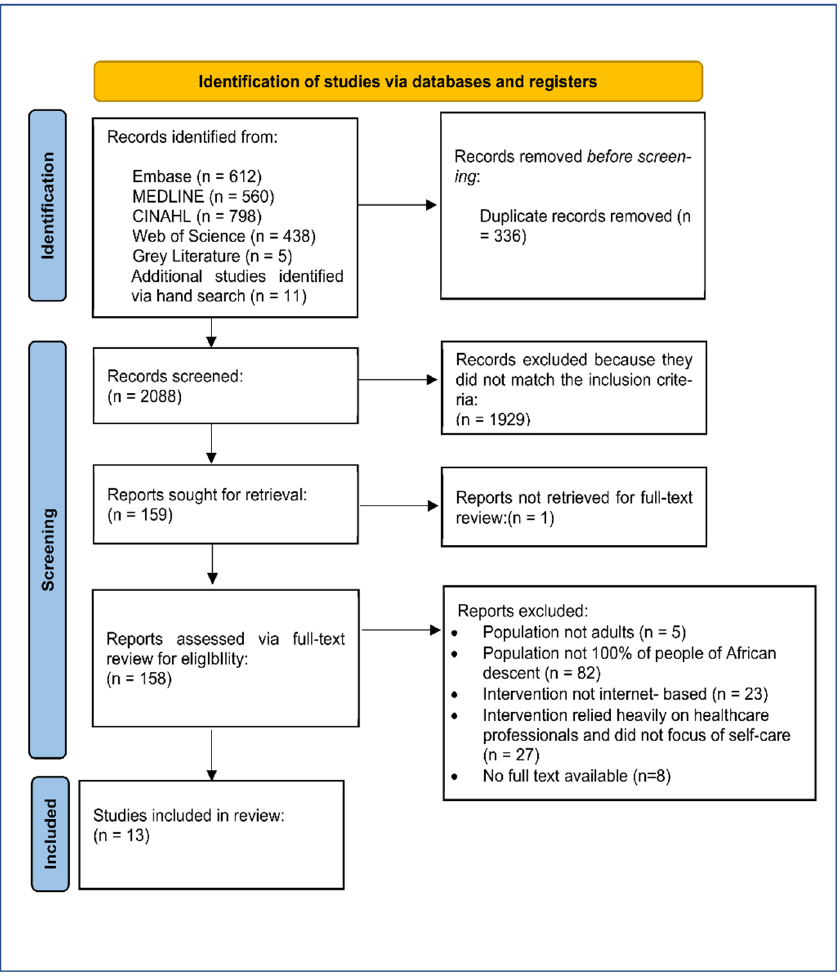
Figure 1. Flow Diagram of Included Studies.